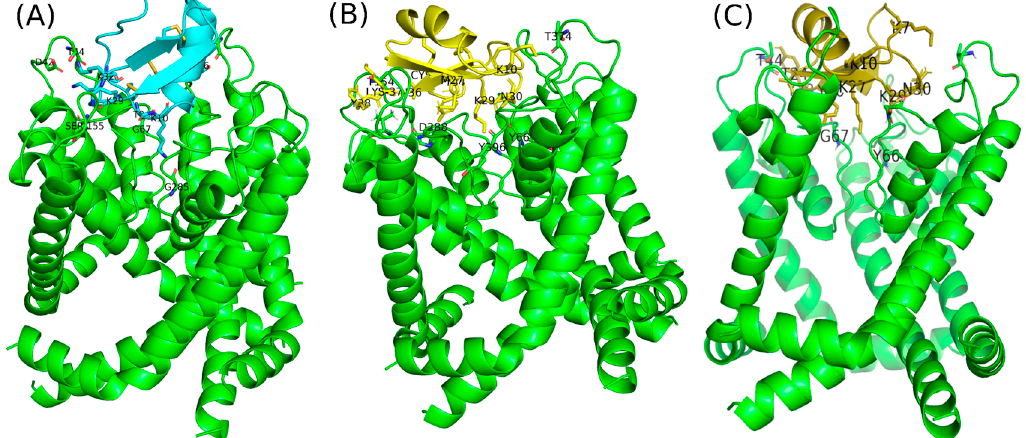
Figure 6. Protein–Protein docking of the Bot33 toxin and its mutations with the KV1.3 potassium channel. ( A ) Docking complex of Bot33 and Kv1.3 channel. ( B ) Docking complex Bot33/M27–Kv1.3 potassium channel reveals that the majority of basic residues are implicated in the interaction. ( C ) The interaction of Bot33/K27_Y36 with KV1.3 shows that the beta-sheet of the toxin interacts with the selectivity filter residues of the channel. The pore is physically blocked with the K27 lateral chain of Bot33/K27_Y36.